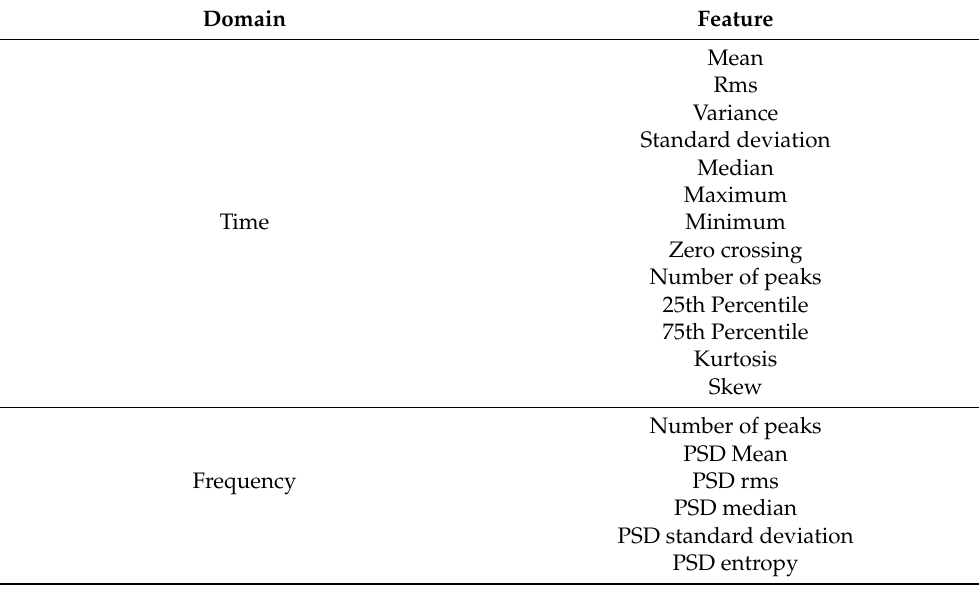
Table 3. Features computed for each data; N f =